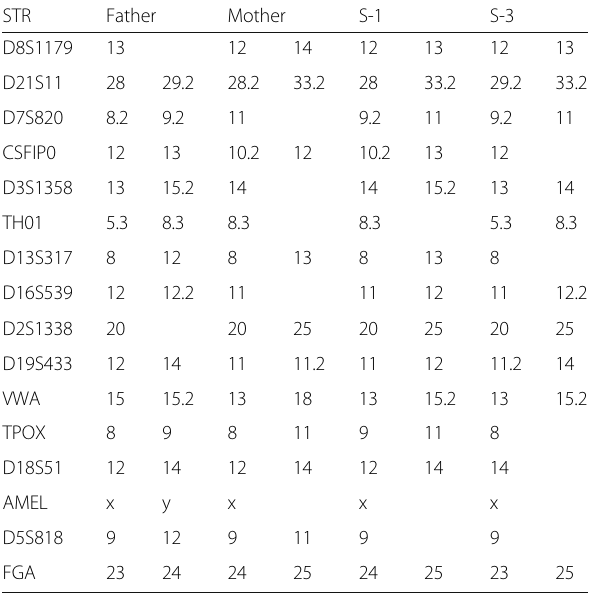
Table 3 Forensic analysis of family members using 16 STR markers